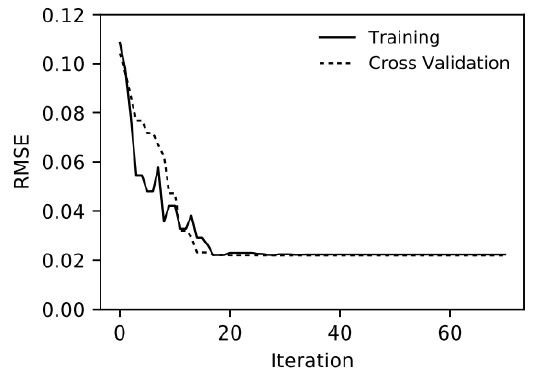
Figure 9. Learning Curve .